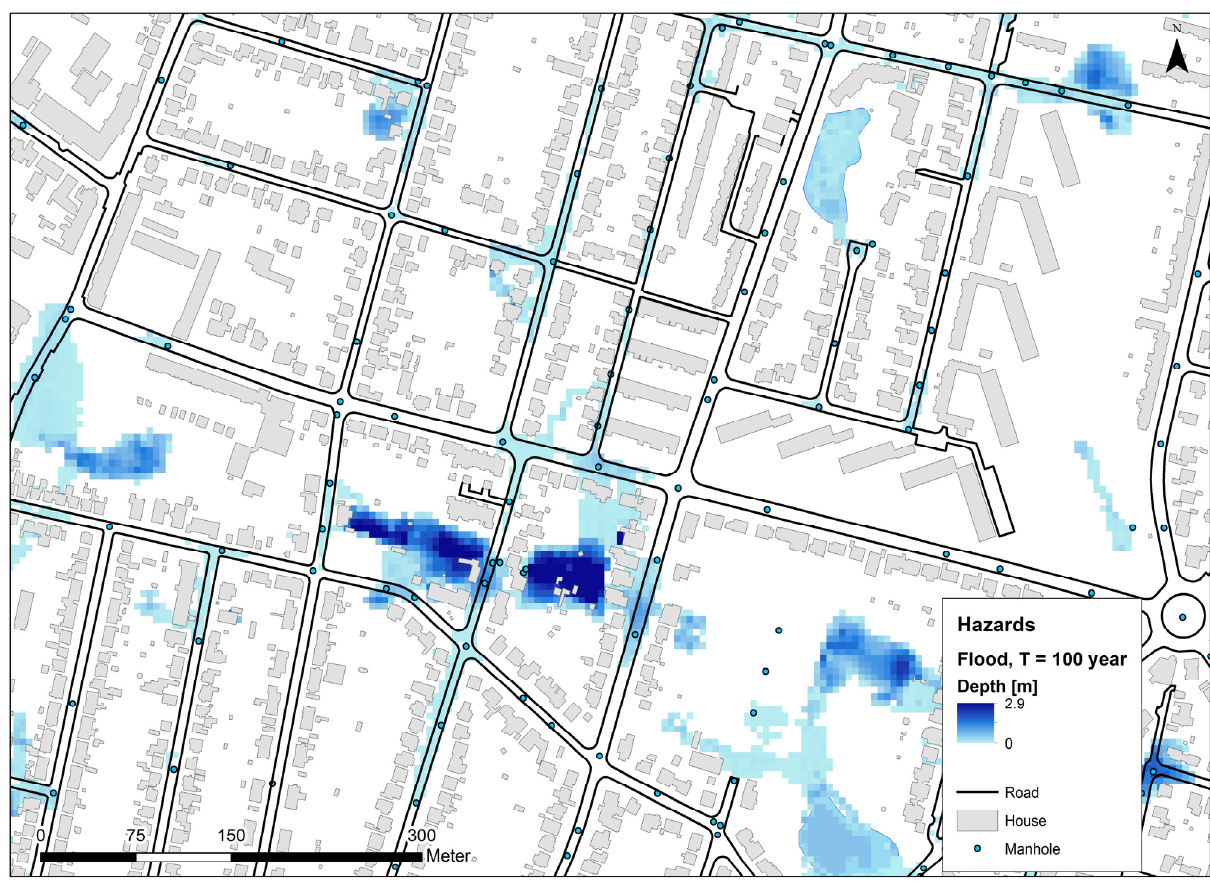
Figure 2. The result of the flood hazard assessment shows both the extent and the depth of the flooding for a given return period. Here the hazard assessment for a subcatchment in the city of Odense for a 100 year return period is